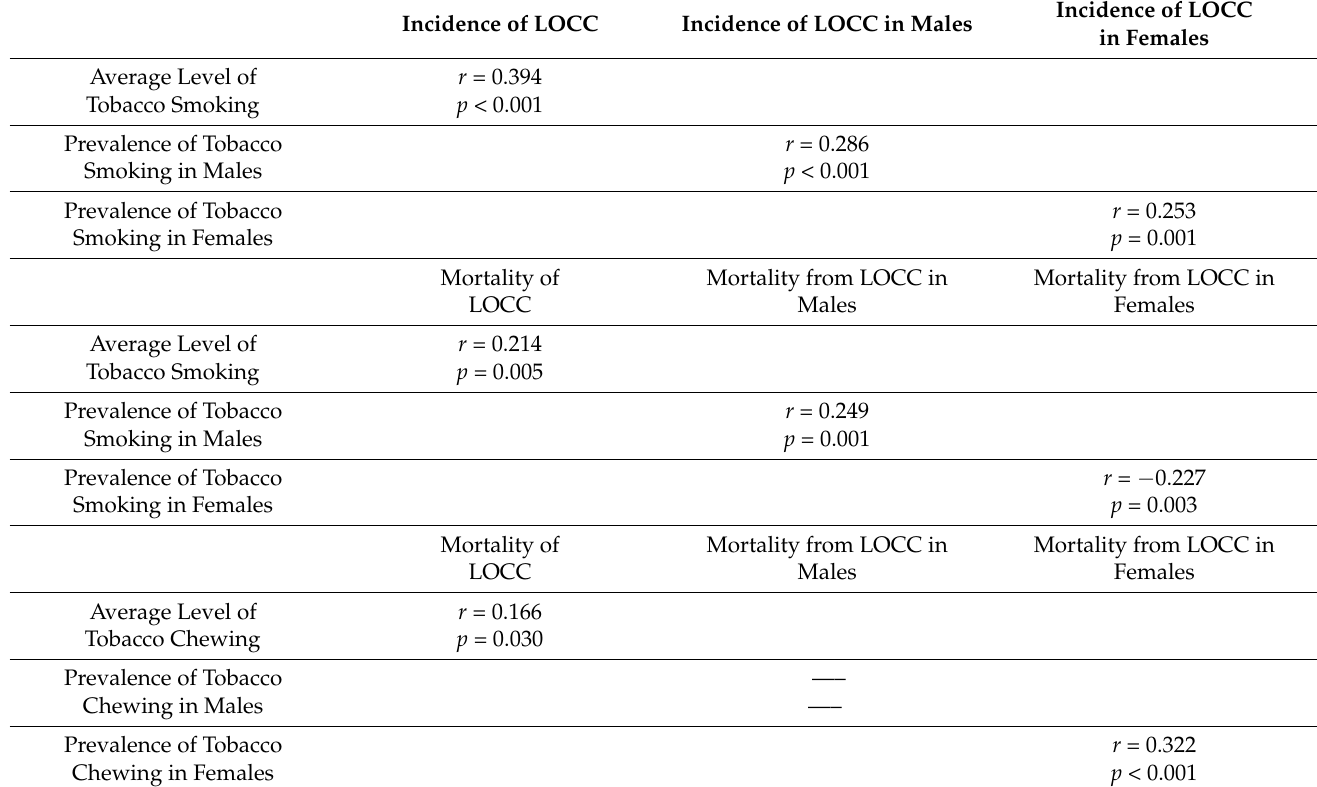
Table 3. Correlation between the prevalence of tobacco smoking and the incidence and mortality of